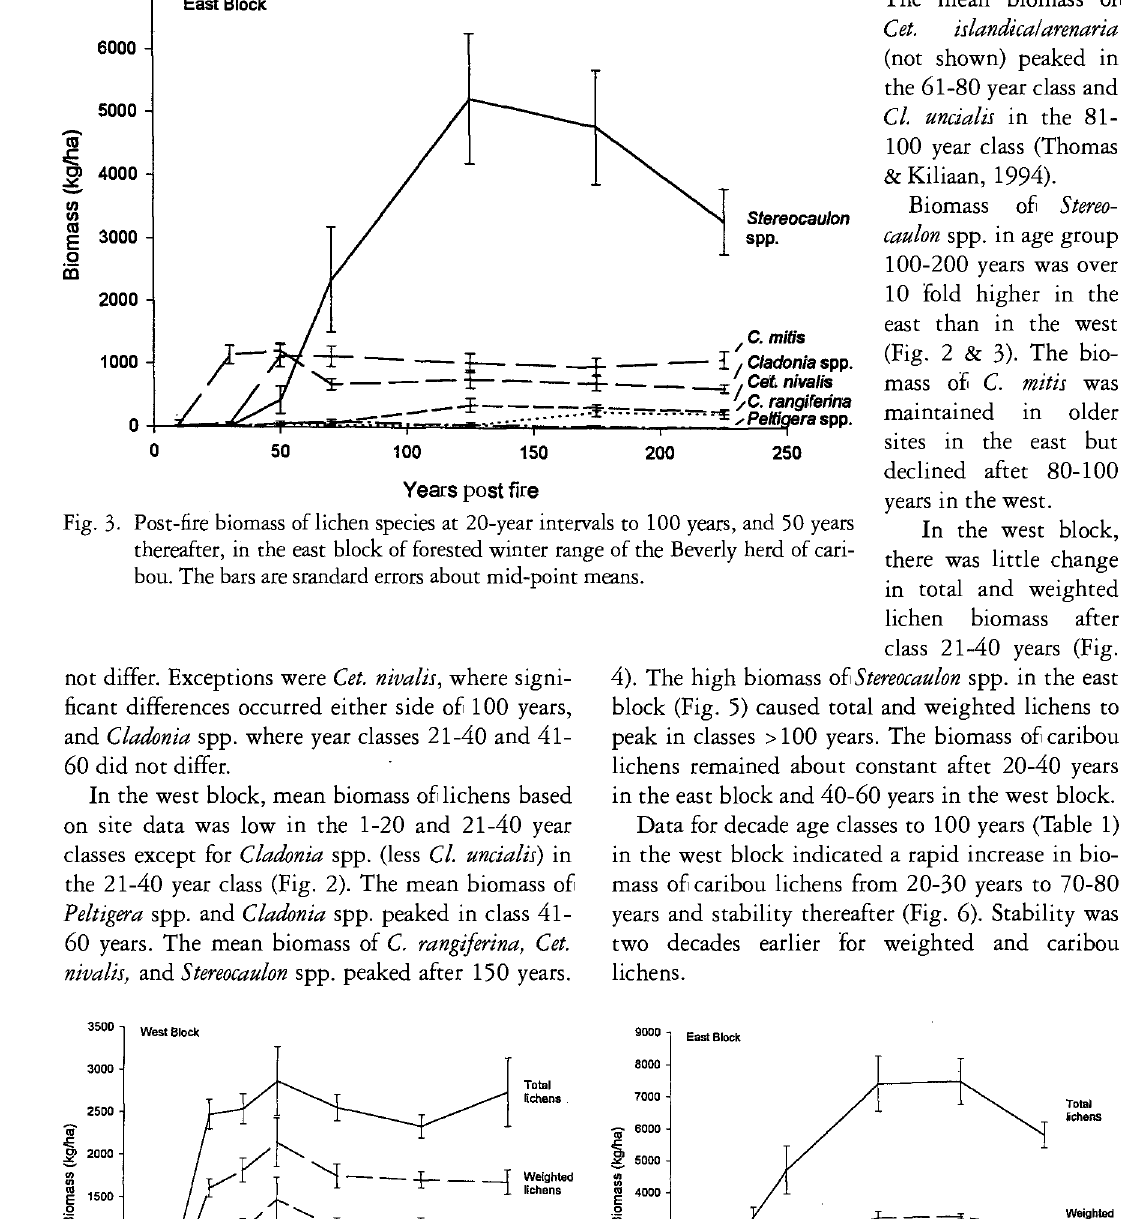
Fig. 5. Post-fire biomass of total, weighted, and "caribou lichens" at 20-year intervals to 100 years, and 50 years thereafter, in the east block of forested win ter range of the Beverly herd of caribou. The bars are standard errors about mid-point